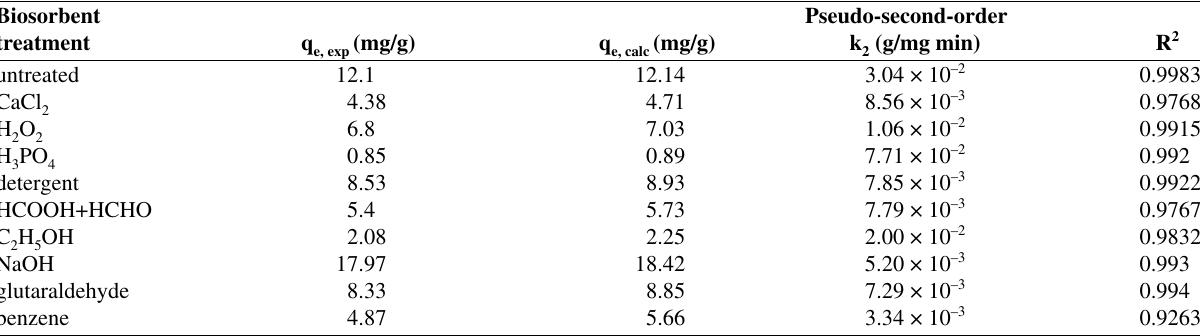
Table 2. Kinetic parameters for Cd 2+ bioadsorption using waste brewery yeast biomass; C pH 5.6, 150